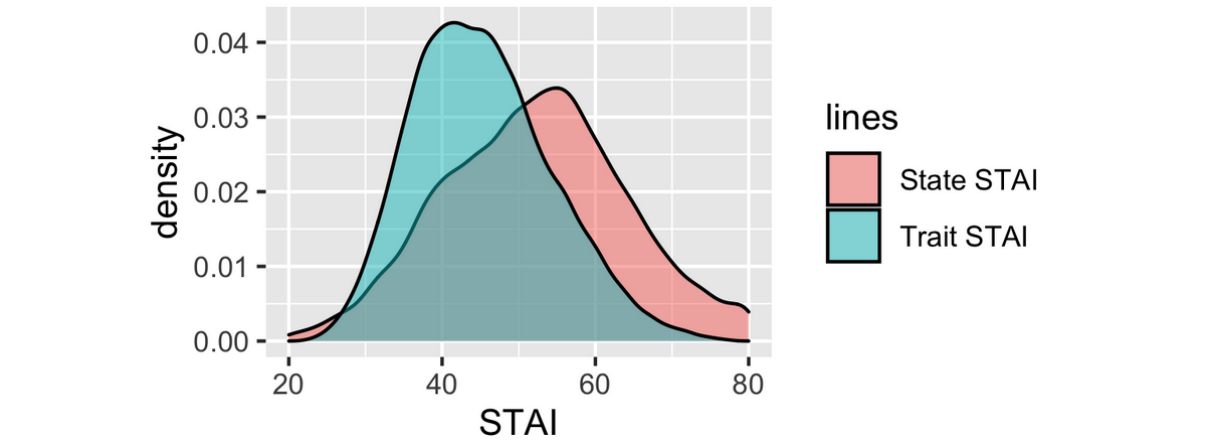
Figure 2. Map of Russia showing the levels of respondents’trait anxiety (T-Anxiety). Areas with data from less than 40 respondents are not shown on the map. T-Anxiety: Trait Anxiety